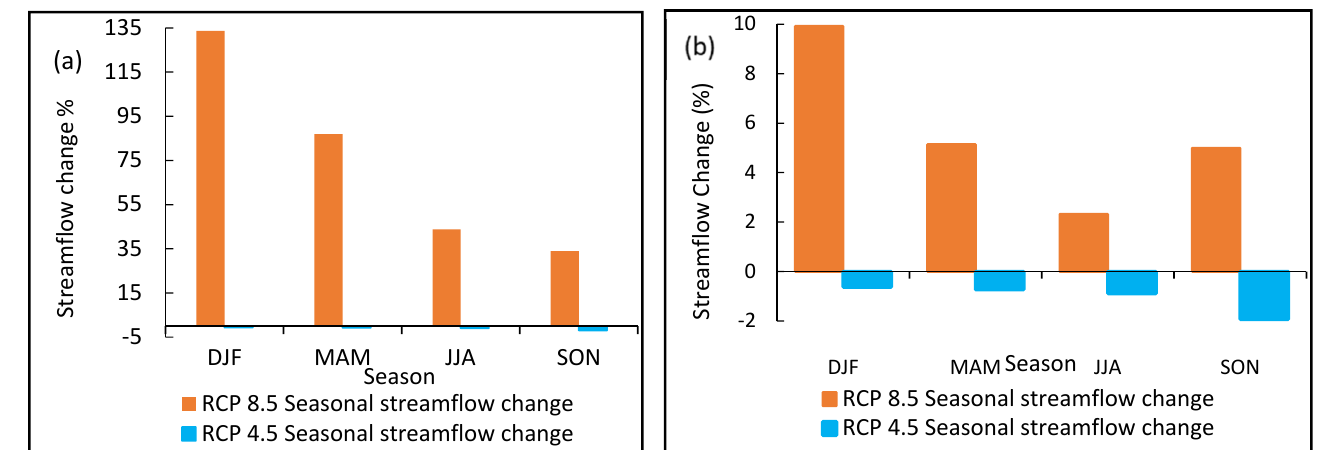
Figure 7. Comparisons of change in seasonal streamflow for ( a ) high uncertainty; and ( b ) strong consensus. The seasonal streamflow in Figure 7 indicates that for RCP 4.5, streamflow will be reduced by − 0.6% in DJF, − 0.7% in MAM, − 1% in JJA and − 2% in SON in both scenarios.